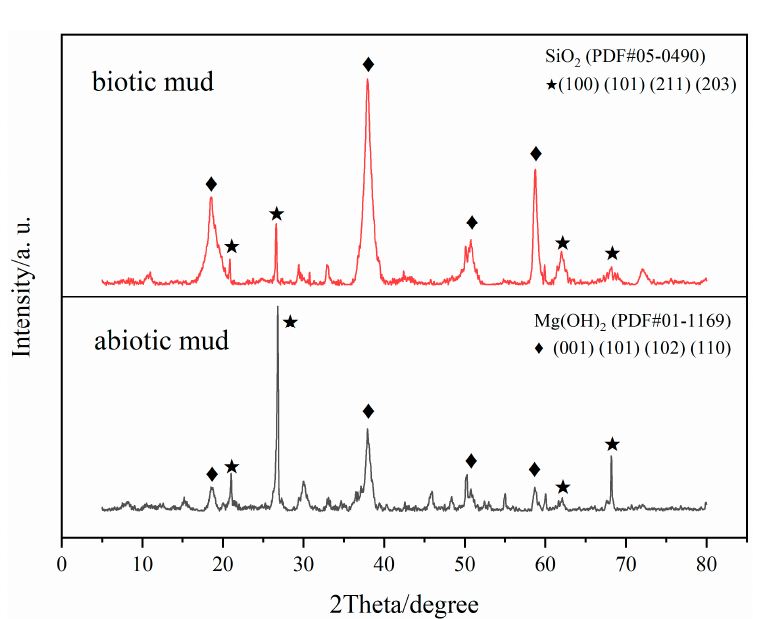
Figure 6. Selected XRD patterns of corrosion products on samples for 14